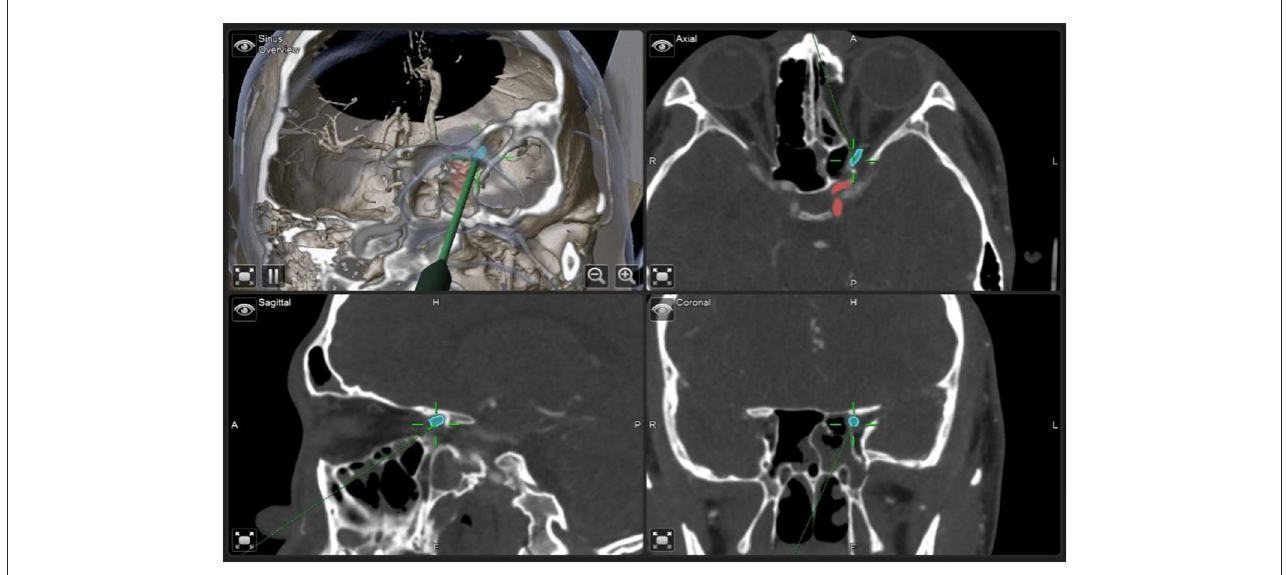
FIGURE1 Real-time positioning of the optic nerve and carotid artery accurately displayed by navigation during ENS. Blue: The optic nerve; Red: Internal carotid artery.